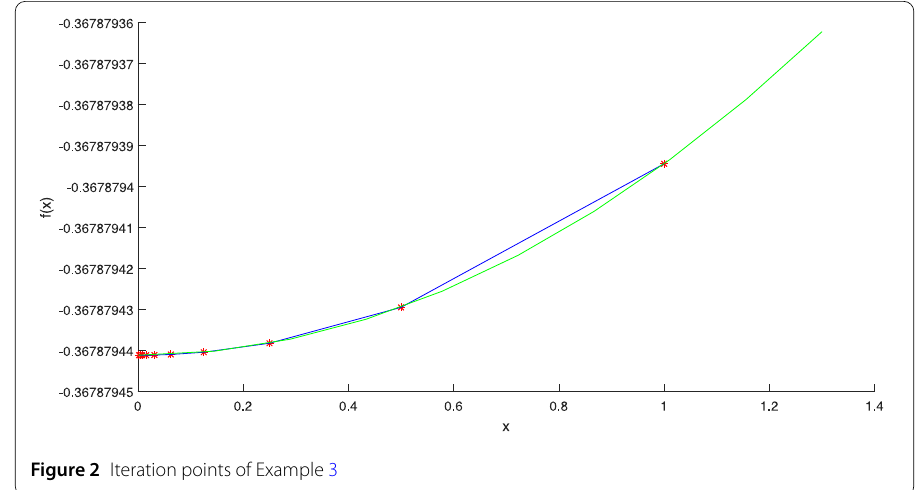
Figure 2 Iteration points of Example